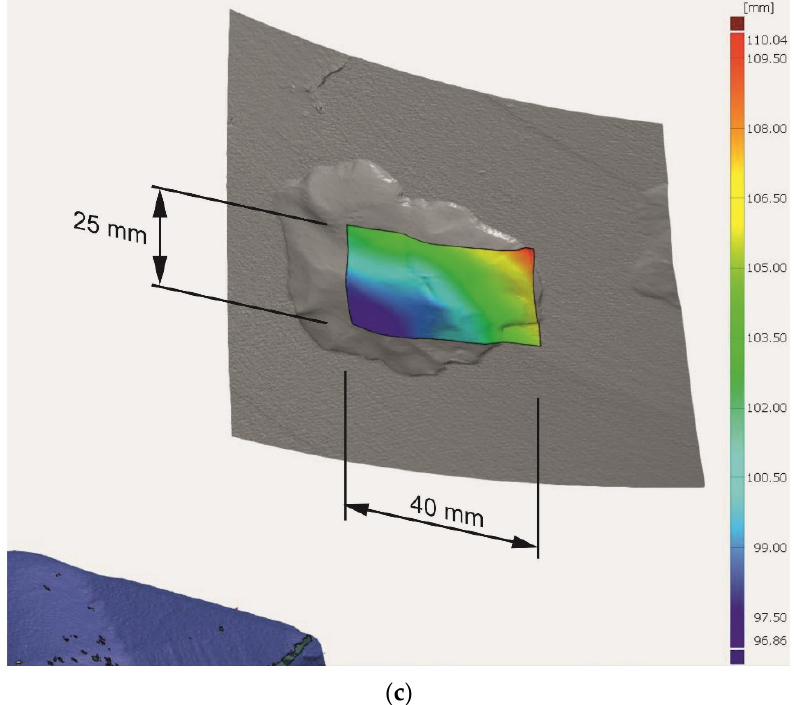
Figure 22. ( a ) Position of the pick holder relative to the cutting head side surface during measurement, ( b ) distribution map of distances of the cutting head side surface from the pick holder base plane obtained using GOM Inspect (GOM GmbH, Braunschweig, Germany) software, and ( c ) distribution map of these distances in the area limited to the dimensions of the pick holder base.